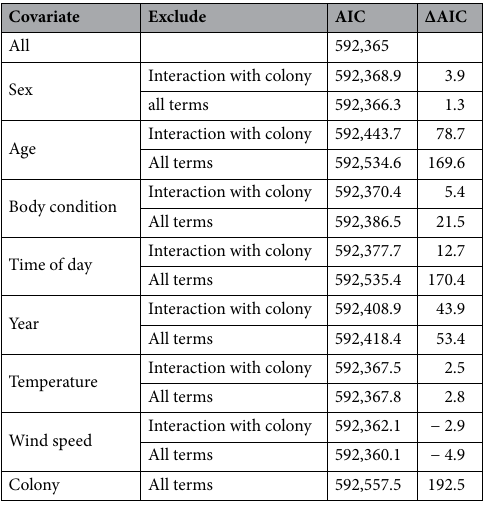
Table 1. Differences in AIC values (ΔAIC) between the full model and HMMs sequentially excluding each variable and its interaction term with